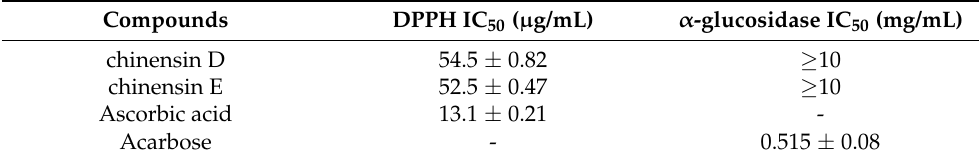
Table 2. Antioxidant and α -glucosidase inhibitory activities of chinensin D and chinensin E. Mean value ± standard deviation ( n = 3). Compounds DPPH IC 50 ( µ g/mL) α -glucosidase IC 50 (mg/mL) chinensin D 54.5 ± 0.82 ≥ 10 chinensin E 52.5 ± 0.47 ≥ 10 Ascorbic acid 13.1 ± 0.21 - Acarbose